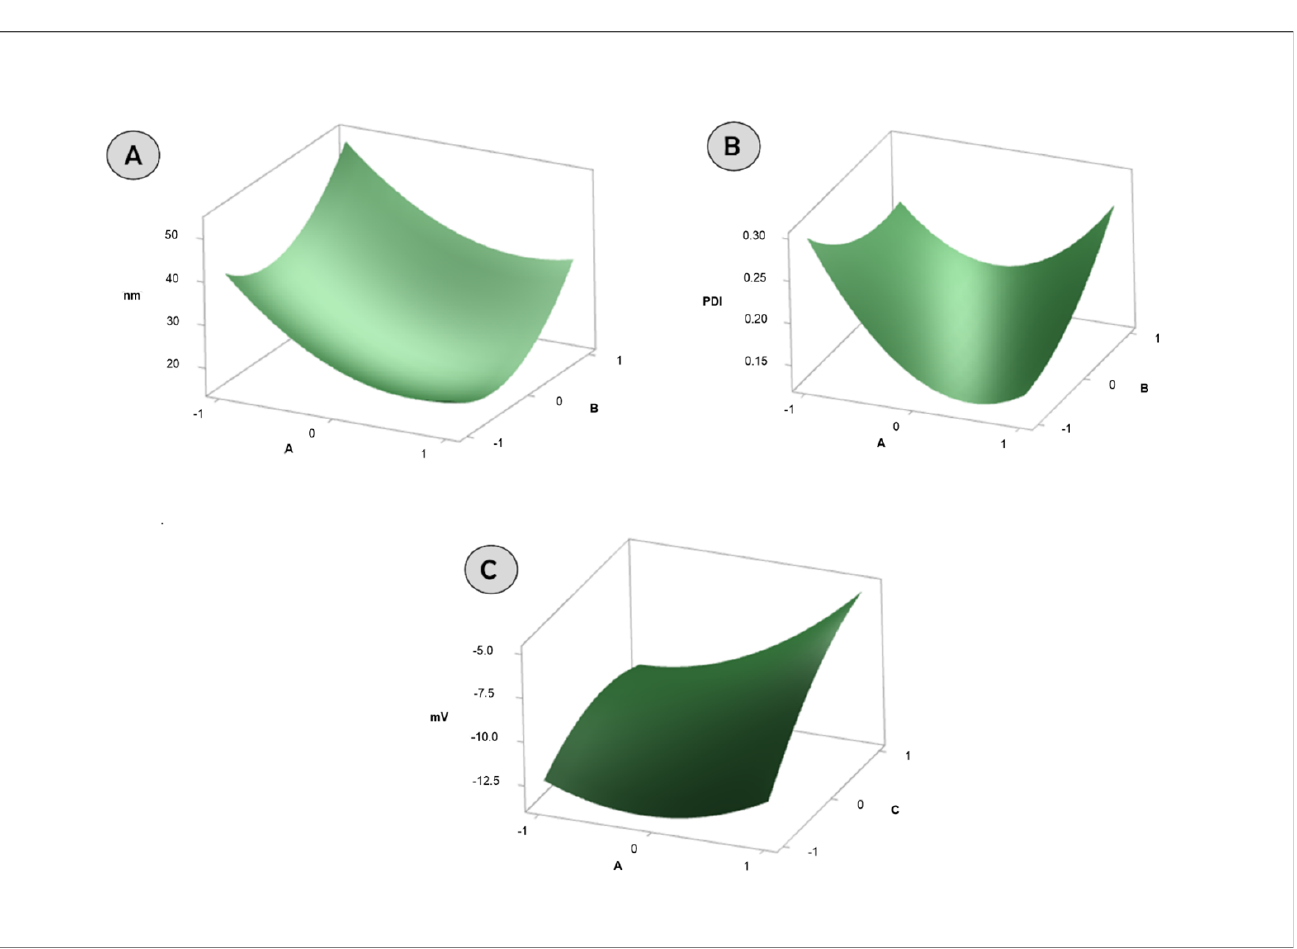
Figure 3. Response surface graphs obtained after BB analysis of the variables: HD ( A ), PdI ( B ), and ZP ( C